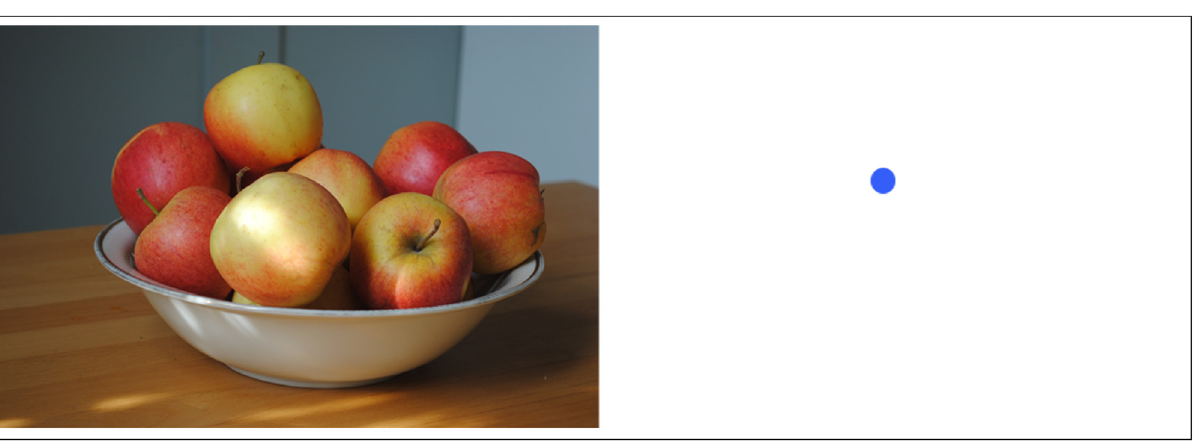
PLOS ONE | https://doi.org/10.1371/journal.pone.0180573 July 10,